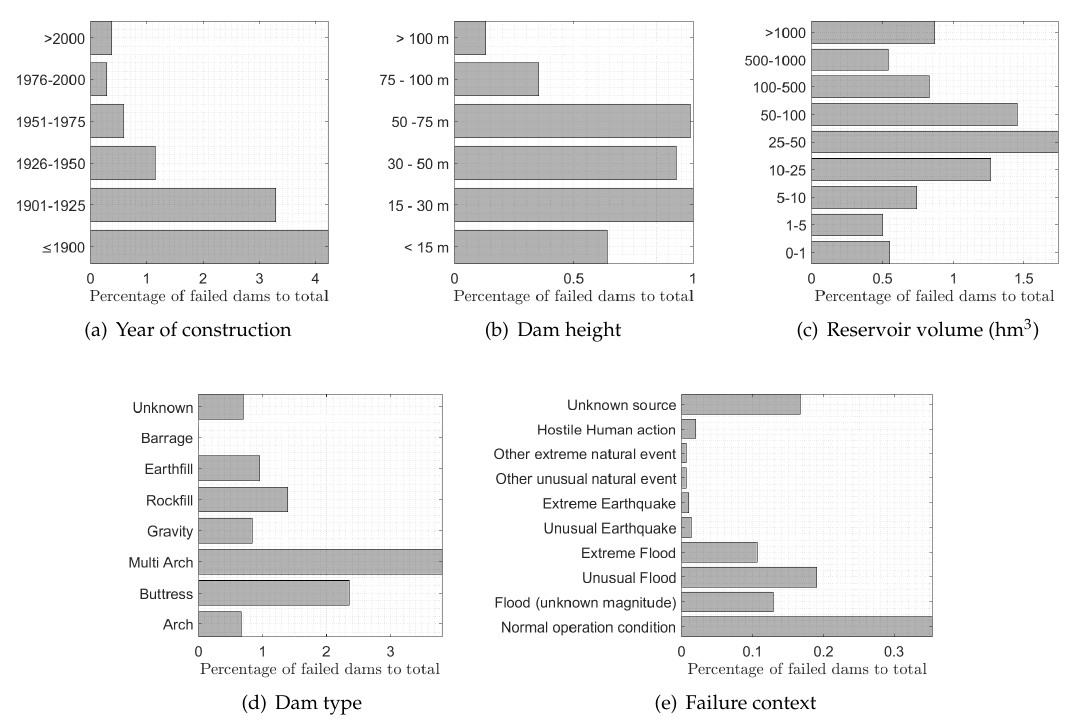
Figure 3. Statistics of large dams failure as a function of different